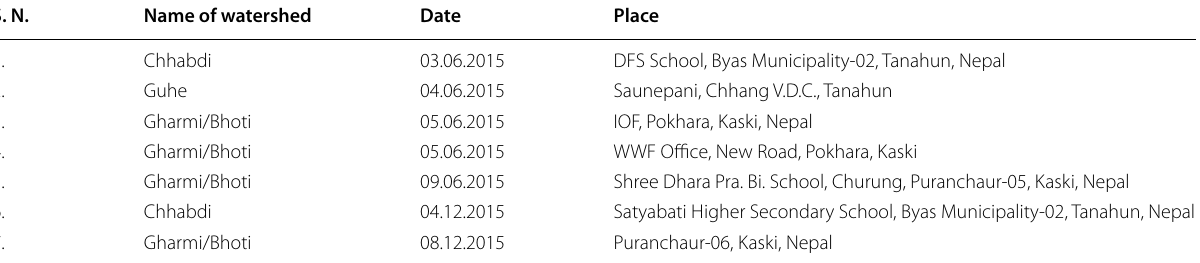
Table 2 People’s perception information meetings were organised on following date and location S.